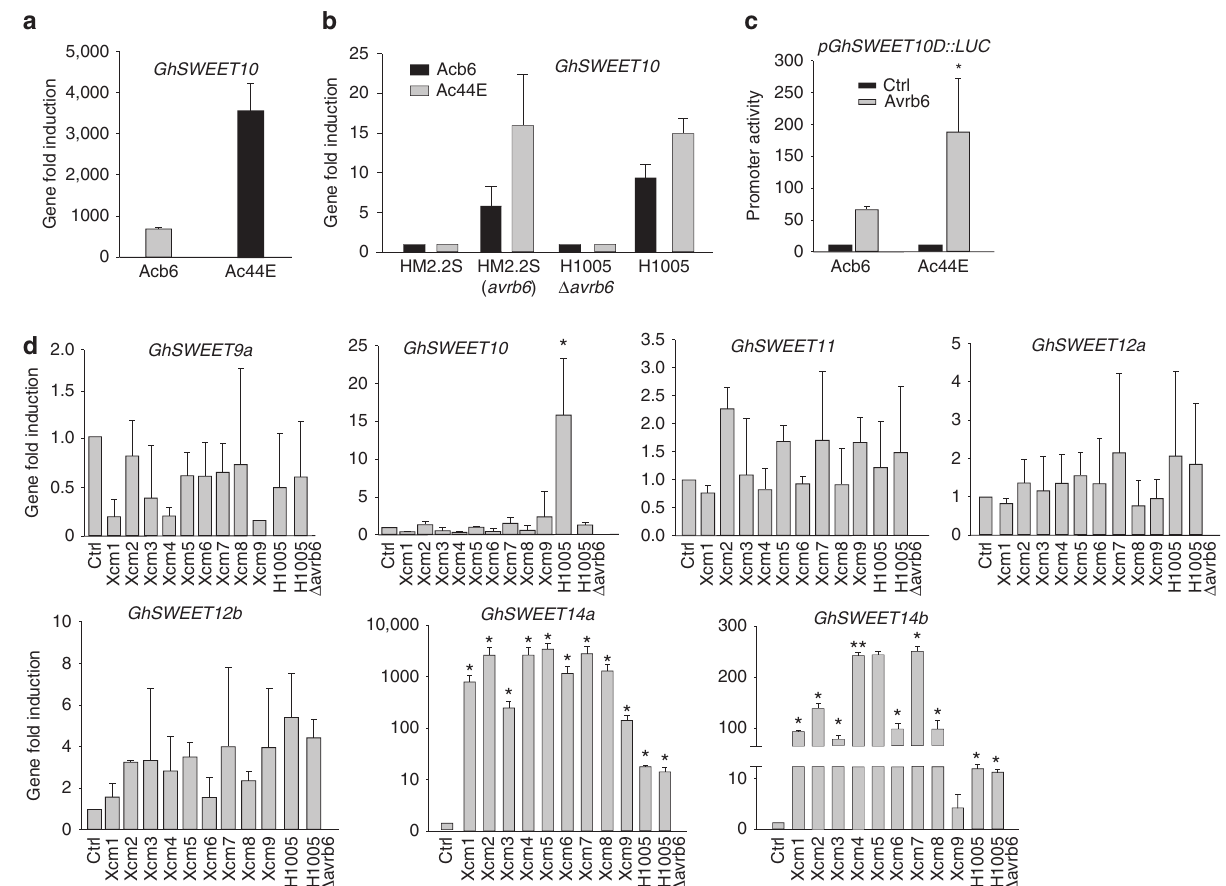
Figure 7 | Induction of GhSWEET genes in different cotton– Xcm interactions. ( a ) GhSWEET10 induction by Avrb6 in protoplasts of the resistant line Acb6 and the susceptible line Ac44E. Graph displays Avrb6-induced GhSWEET10 reads per kilobase of transcript per million mapped reads and fold change from RNA-Seq analysis with Ac44E (compatible) and Acb6 (incompatible) cotton lines. ( b ) qRT–PCR analysis of GhSWEET10 in Ac44E and Acb6 plants upon Xcm infections. Two-week-old cotyledons were syringe-inoculated with different Xcm strains at OD 600 ¼ 0.1 and tissues were collected at 24 hpi. GhUBQ1 was used as an internal control. The data are shown as mean ± s.d. ( n ¼ 3) from three independent repeats. ( c ) Transactivation assay of pGhSWEET10D::LUC from Acb6 and Ac44E in response to Avrb6 in cotton protoplasts. The promoter of GhSWEET10D was amplified from Acb6 and Ac44E, respectively, and fused with luciferase reporter. Protoplasts of cotton variety FM706V were co-transfected with the reporter construct and Avrb6 or an empty vector control (Ctrl). The data are shown as mean ± s.d. ( n ¼ 3) from three independent repeats. An asterisk indicates the significant difference using two-tailed t -test ( P o 0.05) between two reporter constructs after Avrb6 induction. ( d ) Induction of clade III GhSWEET genes by different Xcm isolates. Two-week-old cotyledons were syringe-inoculated with different Xcm isolates ( Xcm1-Xcm9 ) collected from different locations in Texas, USA at OD 600 ¼ 0.1. Tissues were collected at 24 hpi. GhUBQ1 was used as an internal control for qRT–PCR analysis. The data are shown as mean ± s.d. ( n ¼ 3) from three independent repeats. An asterisk indicates significant difference using two-tailed t -test ( P o 0.01) compared to the water control. The above experiments were repeated three times with comparable